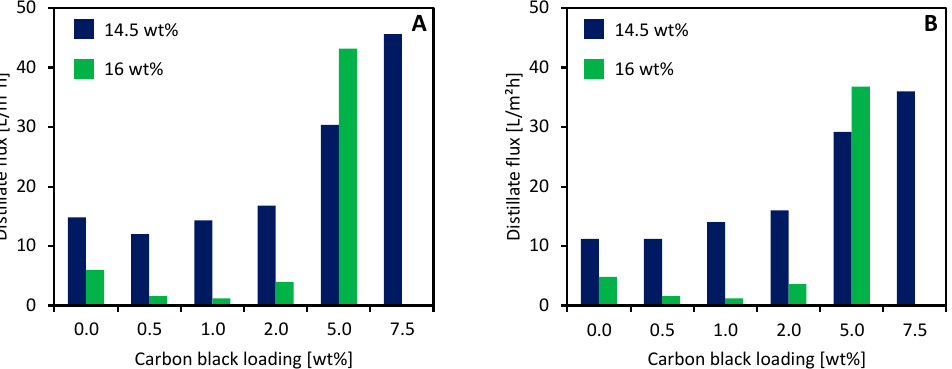
Figure 8. Mean distillate fluxes obtained with CB-loaded membranes using ( A ) pure H 2 O and ( B ) a 90 g/L NaCl solution as feed.